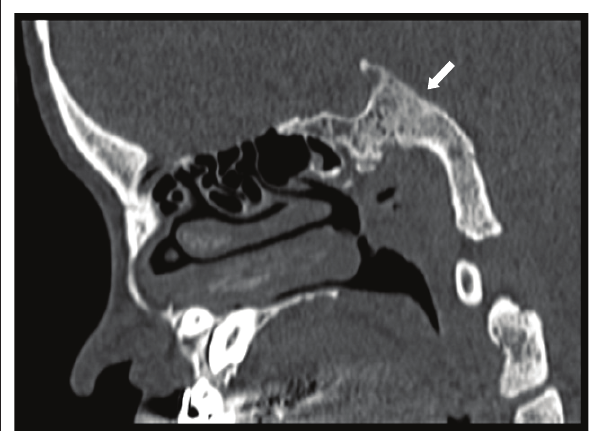
FIGURE 5: Sagittal-section computed tomography scan shows a dysplastic clivus with its flexion deformity and convexity towards the endocranium (arrow).